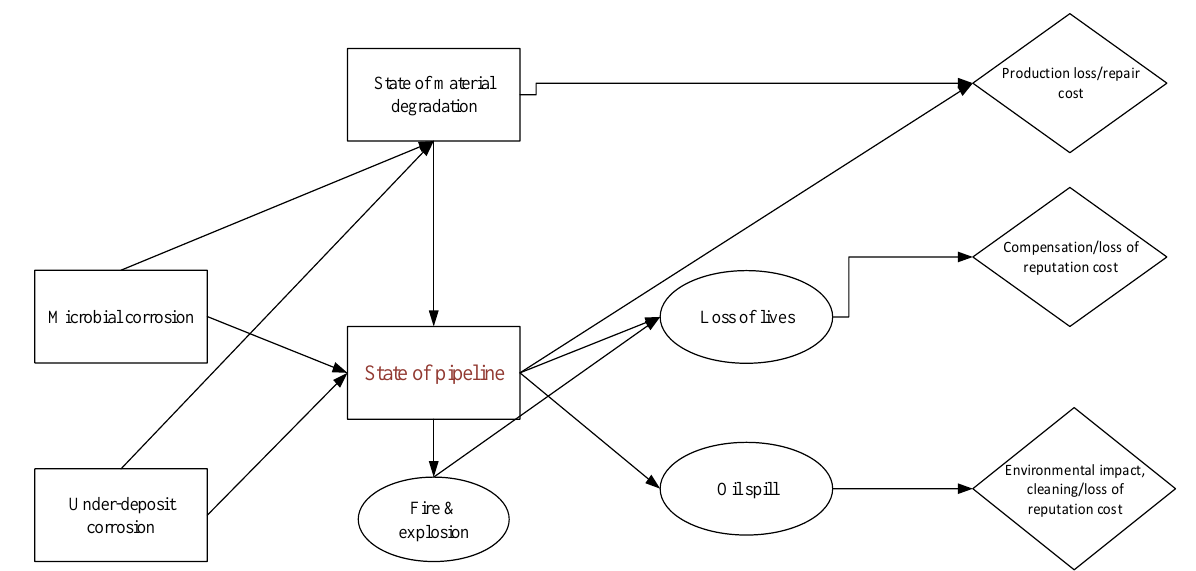
Figure 1. An influence-based framework for consequence assessment due to stochastic degradation.